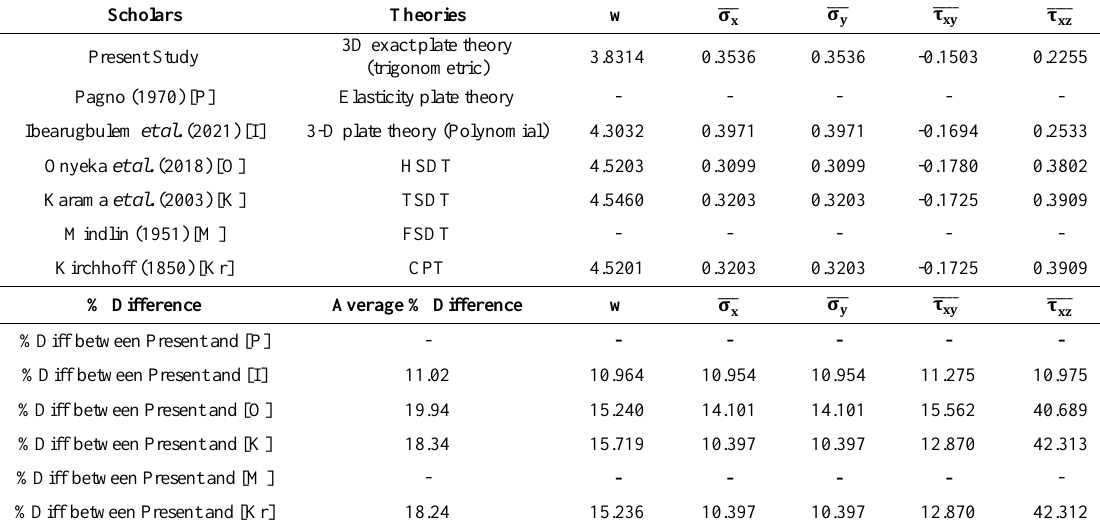
Table 4. Non dimensional forms of displacement and stresses of SSSS plate at aspect ratio of b/a = 1.0 and a/t=100.